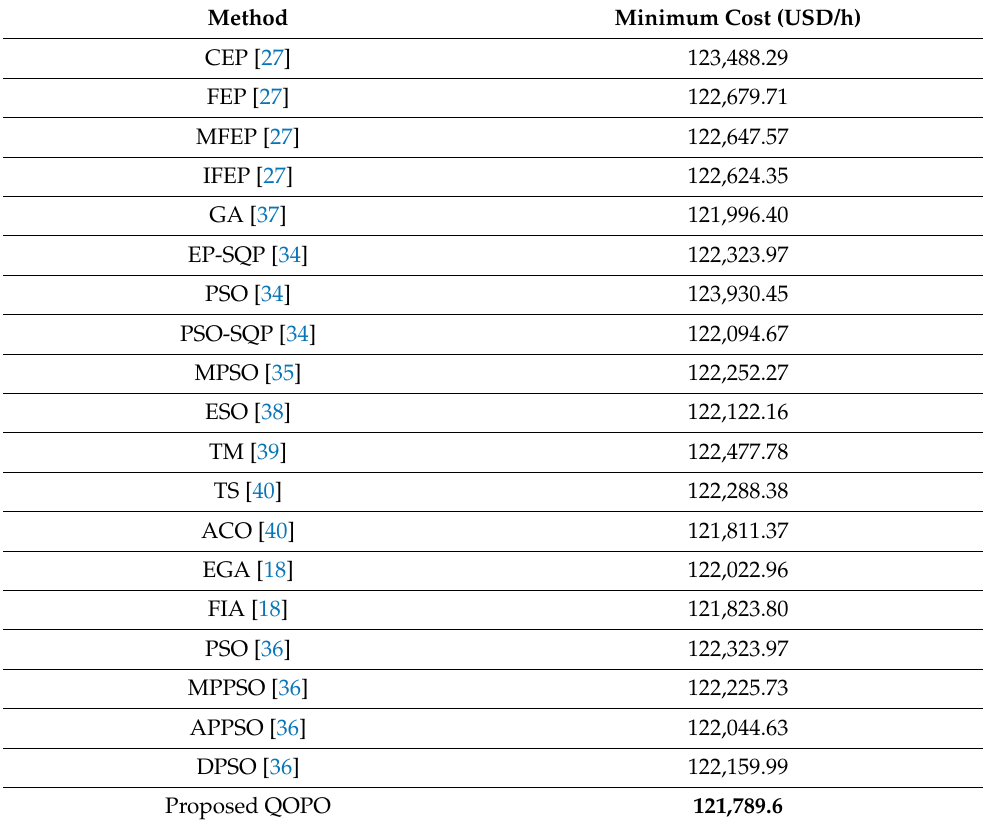
Table 8. Comparison of results of 40-unit system for the load demand of 10,500